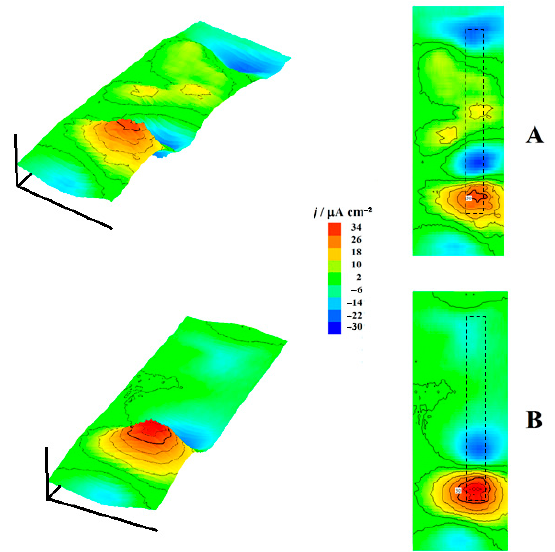
Figure 8. SVET maps recorded for the cut edge of a complete coil coating steel sample immersed in a 1 mM NaCl solution (corresponding to sketch #1 in Figure 1C). The images were obtained after ( A ) 15 and ( B ) 165 min immersion in the test solution. The approximate location of the specimen is indicated by the drawn rectangles. The images represent, in X and Y directions, 1010 μ m × 2790 μ m. Values of Z axis: Ionic current, μ A cm –2 . Mean probe-substrate distance: 100 μ m.